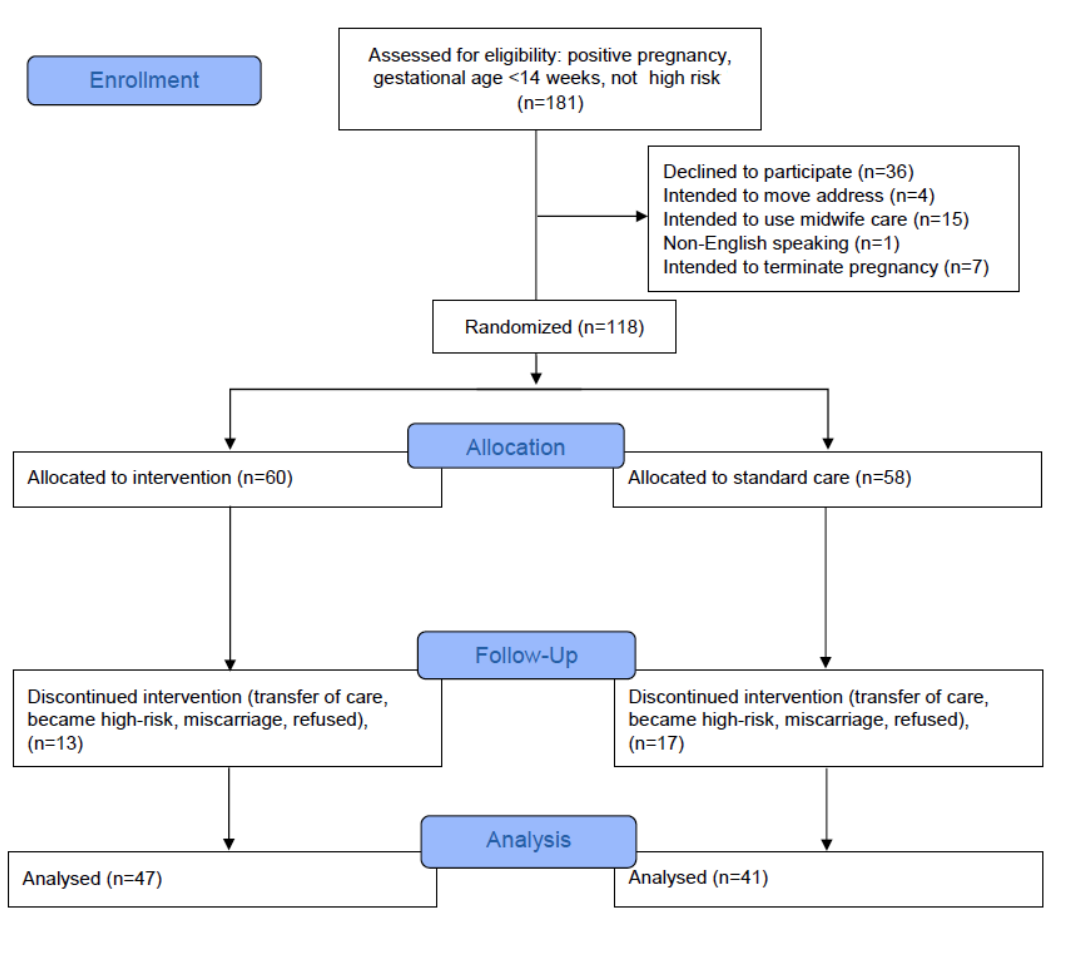
Table 2. Patient characteristics and number of visits per group.